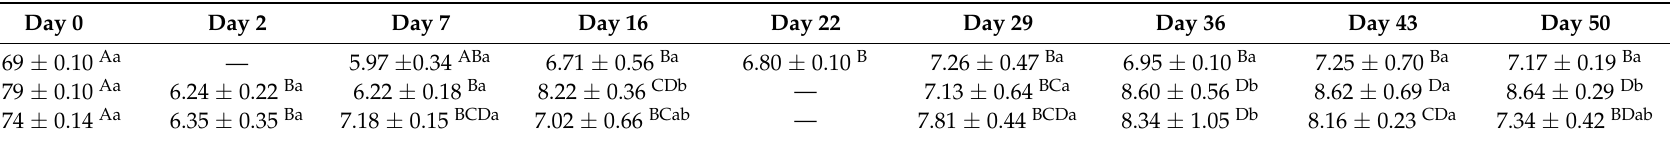
Table 3. Total viable count comparison for sausages with different casings during 50 days of cold storage (4 ◦